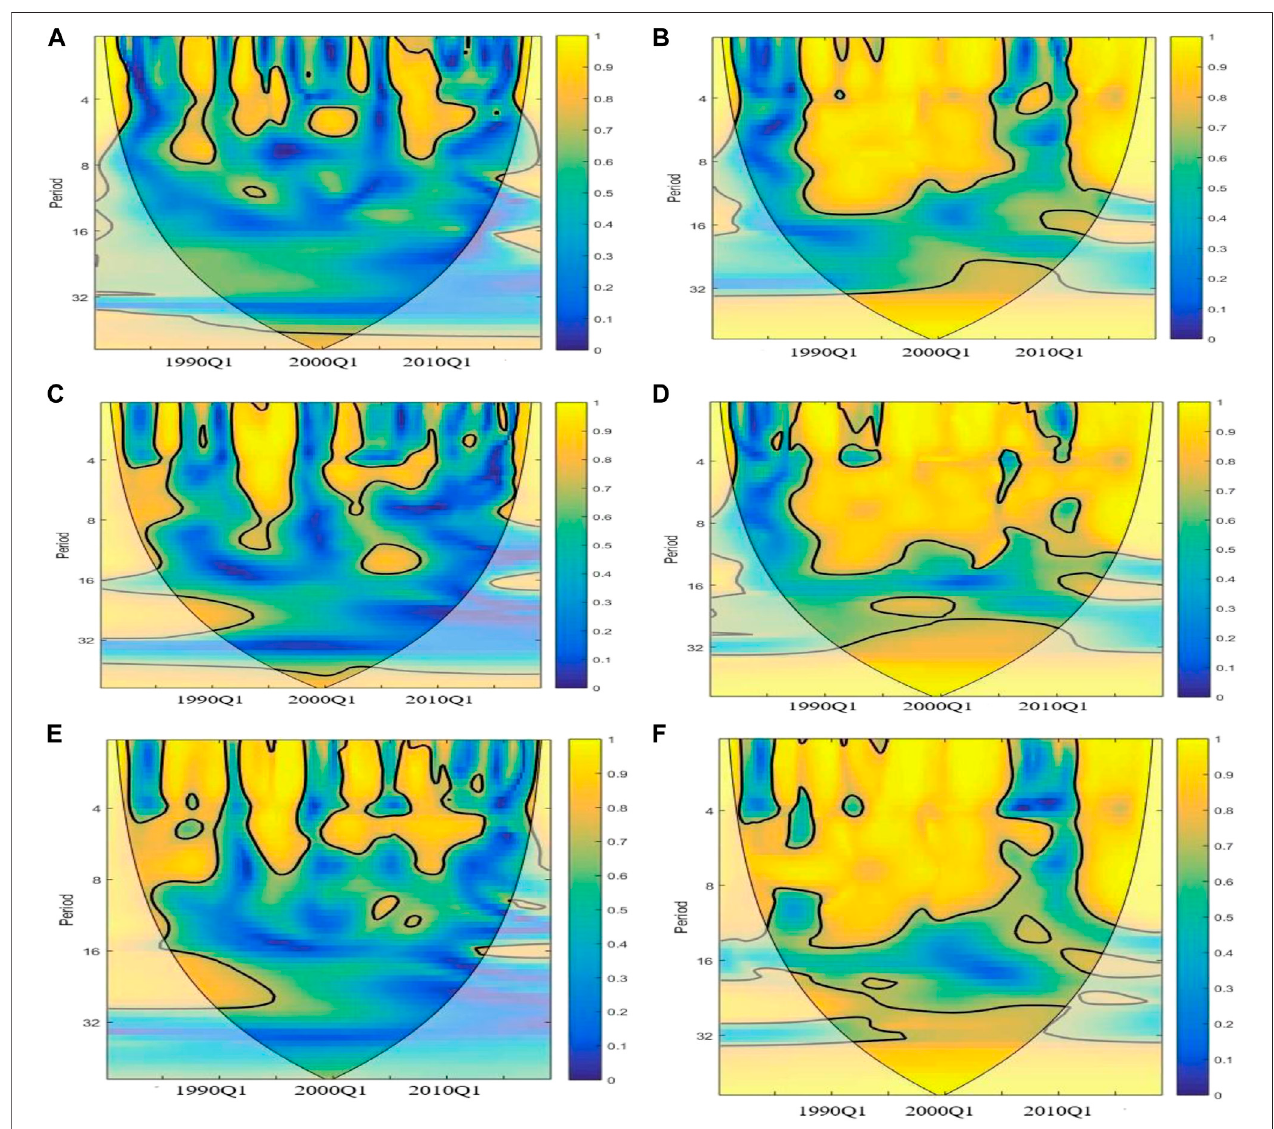
FIGURE 8 | (A) MWC CO2-GDP-GLO. (B) CO2-GDP-TI. (C) CO 2 -GDP-TI. (D) CO 2 -GLO-REN. (E) CO 2 -GLO-TI. (F) CO 2